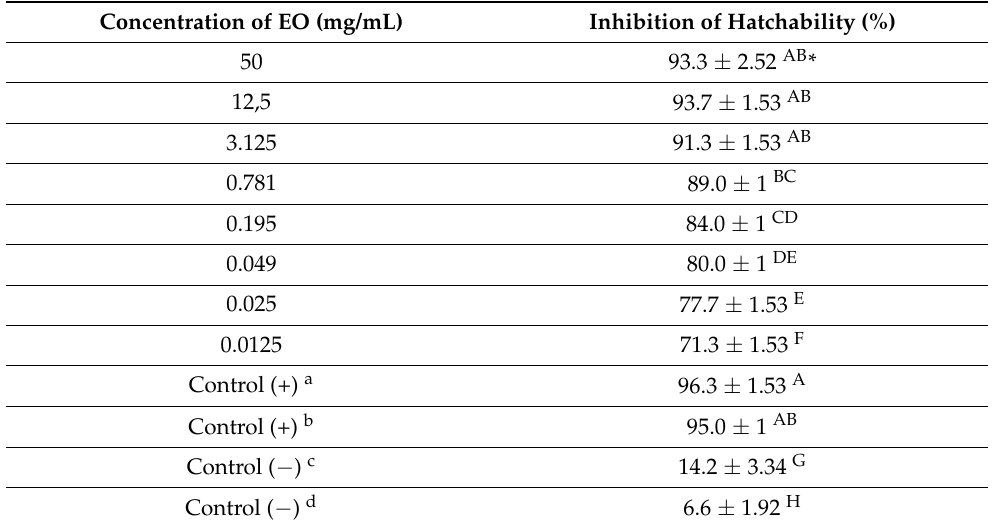
Table 2. The inhibitory effect (mean ± standard deviation) of different concentrations of the Origanum vulgare essential oil on egg hatching of sheep gastrointestinal nematodes.